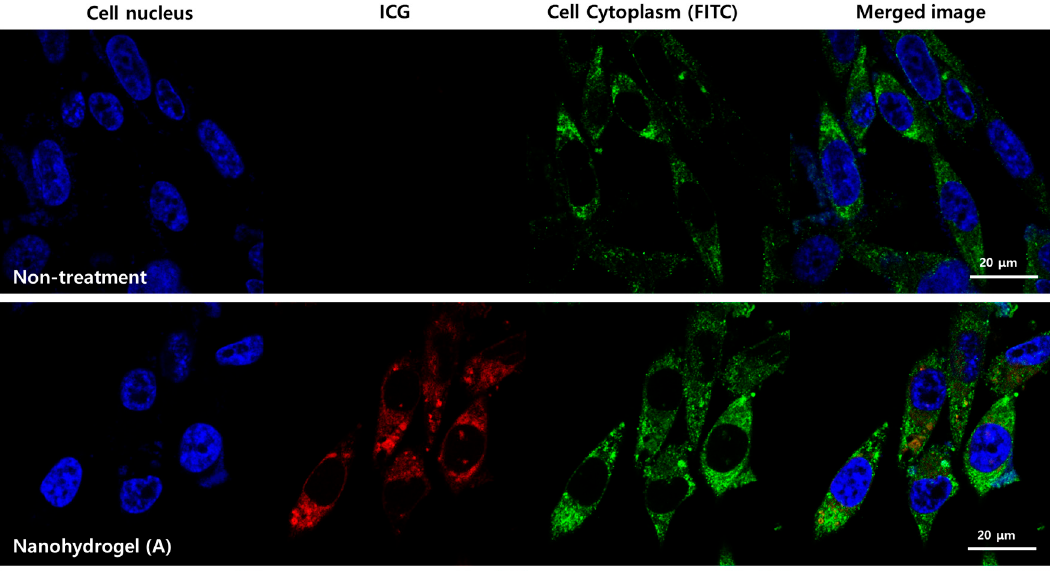
Figure 5. Confocal laser scanning microscopy (CLSM) images of the MDA-MB-231 cells incubated with the nanohydrogels for 13 h. The merged image shows the overlay of a blue filter for the cell nucleus (Hoechst 33324), a red filter for the ICG fluorescence, and a green filter for the cell cytoplasm. 2.5. Transdermal Penetration of the Nanohydrogels in Pig Skins An ex vivo skin permeation study was performed to confirm the effect of HA–Do on the skin permeation enhancement of nanohydrogels using Franz diffusion cells and confocal laser scanning microscopy (CLSM) images. We used nanohydrogel (A) for this skin permeation study, because it had a suitable size to internalized into the cell. We used ICG as a model lipophilic ingredient to easily measure the skin permeation degree of the nanohydrogels by fluorescence (Figure 6). After 24 h of permeation, free ICG without HA–Do was only observed in the upper layer of the epidermis, and it did not permeate into the stratum corneum. In contrast, the ICG-containing nanohydrogel (A) was observed with enhanced fluorescence in both the stratum corneum and epidermis layers, and in the dermis through diffusion from the stratum corneum to the dermis [14,46–48]. Due to the use of low molecular weight HA (20 kDa), nanohydrogel (A) can significantly penetrate the stratum corneum, which is the most superficial layer of the epidermis (Figure 6) [19]. As the permeation time increased, nanohydrogel (A) localized in the deep skin layers, as indicated by the strong fluorescence, due to its good permeation. Particularly, a significant amount of nanohydrogel (A) accumulated in the stratum corneum and epidermis after 48 h, and then, it deeply permeated into the dermis layer at 72 h.